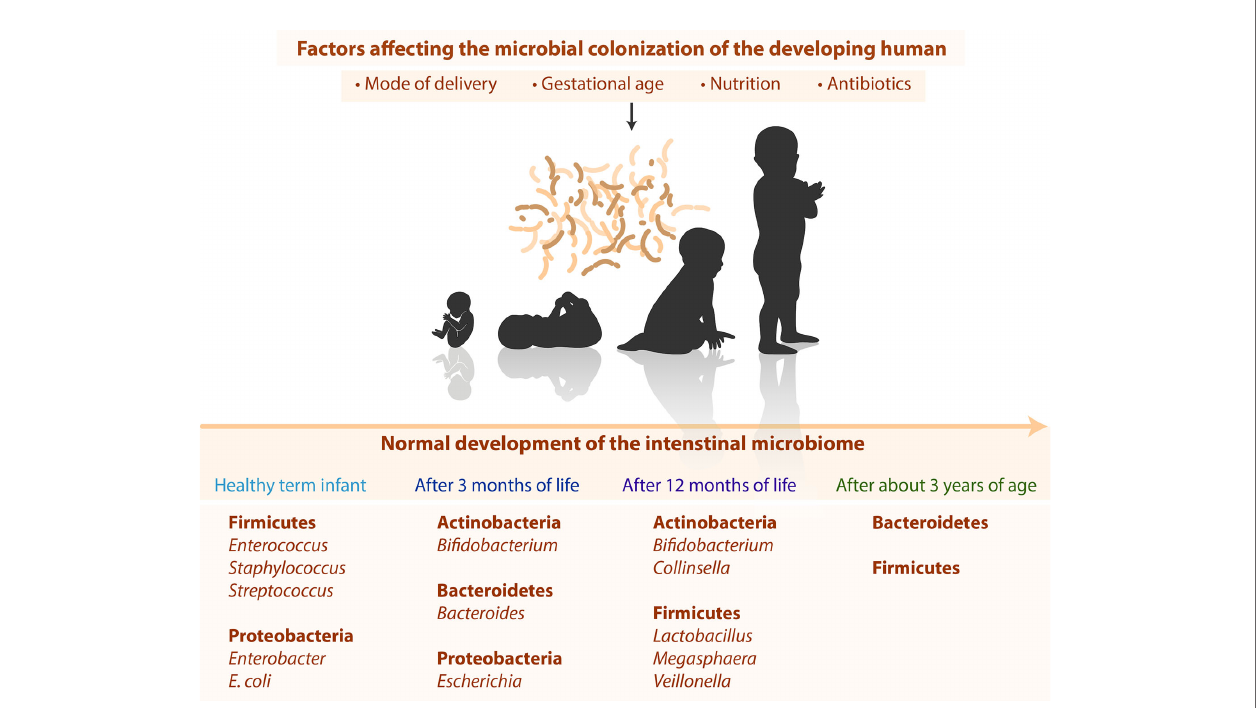
FIGURE 1 | Summary of different factors and timely changes of the infant